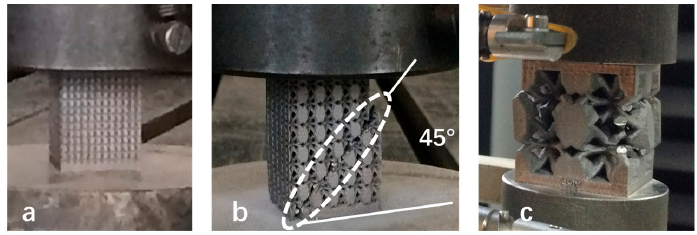
Figure 12. Compressive failure mode corresponding to three categories from compressive stress-strain curves, ( a ) to stress-strain curves in black color without stress peak and plateau; ( b ) to stress-strain curves in blue color with stress peak and plateau; ( c ) to stress-strain curves in green color with stress peak and no plateau.